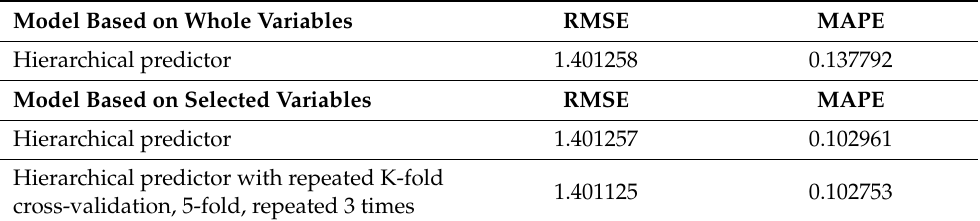
Table 4. The predictive accuracy of proposed